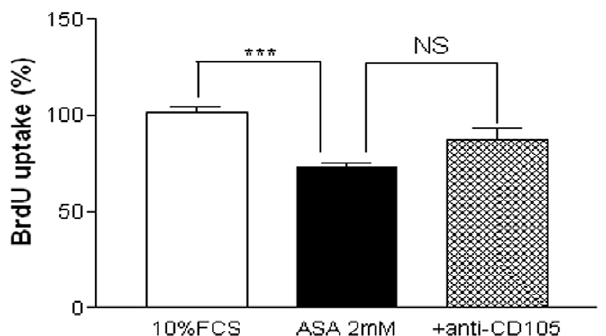
Figure 6. The antiproliferative effect of ASA is independent of endoglin. Effect of anti-CD105 (anti-endoglin, 1 m g/ml) on the antiproliferative effect of ASA (2 mM). Bar graphs show the mean 6 S.E.M of n=4 experiments (cell cultures from 4 different patients).